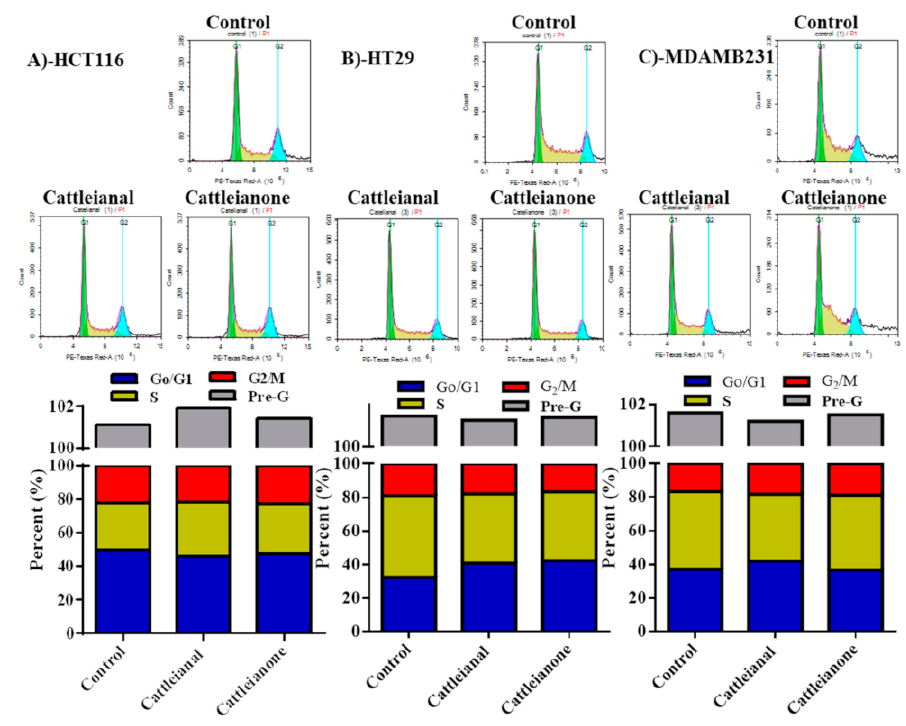
Figure 2. Cell cycle analysis after 24 h incubation with Cattleianal and Cattleianone at their IC 50. Cell cycle analysis using flow cytometry and diagrammatic presentation of the results after the incubation of Cattleianal and Cattleianone with HCT-116 ( A ), HT-29 ( B ) and MDA-MB-231 ( C ) at their IC 50